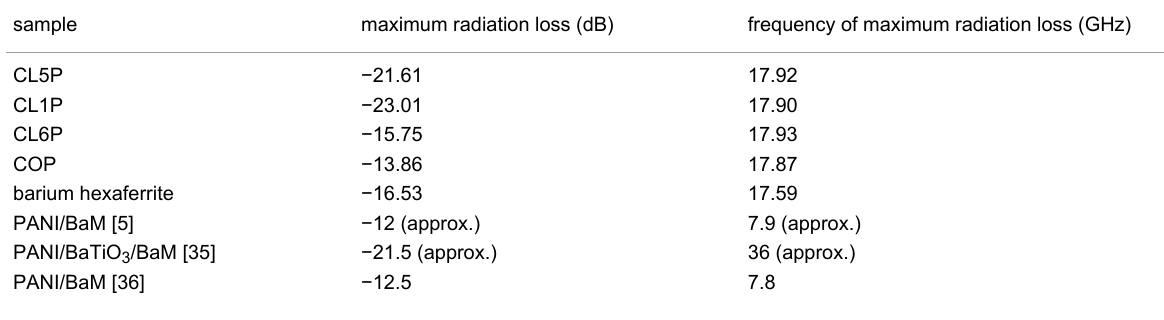
Table 4: Maximum reflection loss for